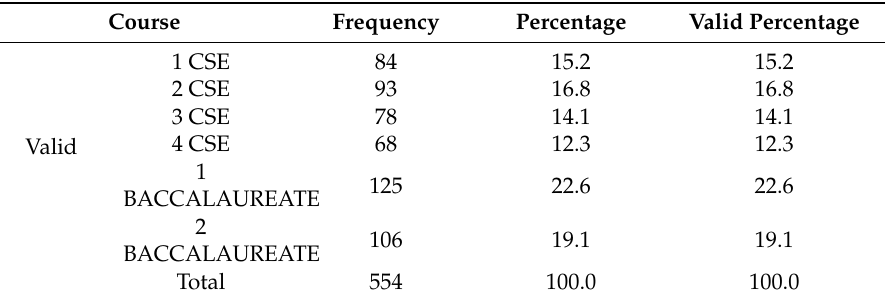
Table 2. Frequencies for the demographic variables according to level of